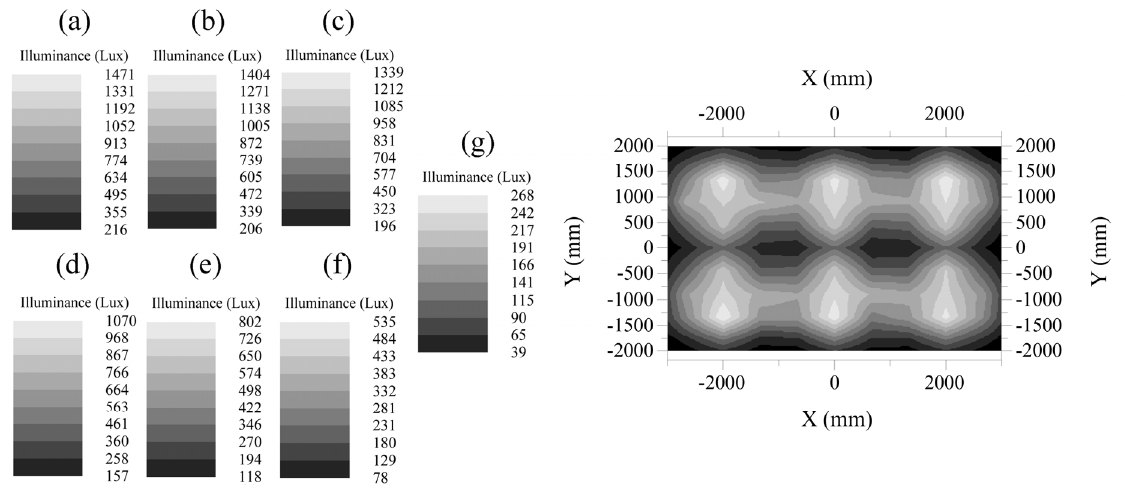
Figure 8. Illuminance distribution on the working plane by daylight at ( a ) 12:00, ( b ) 13:00,